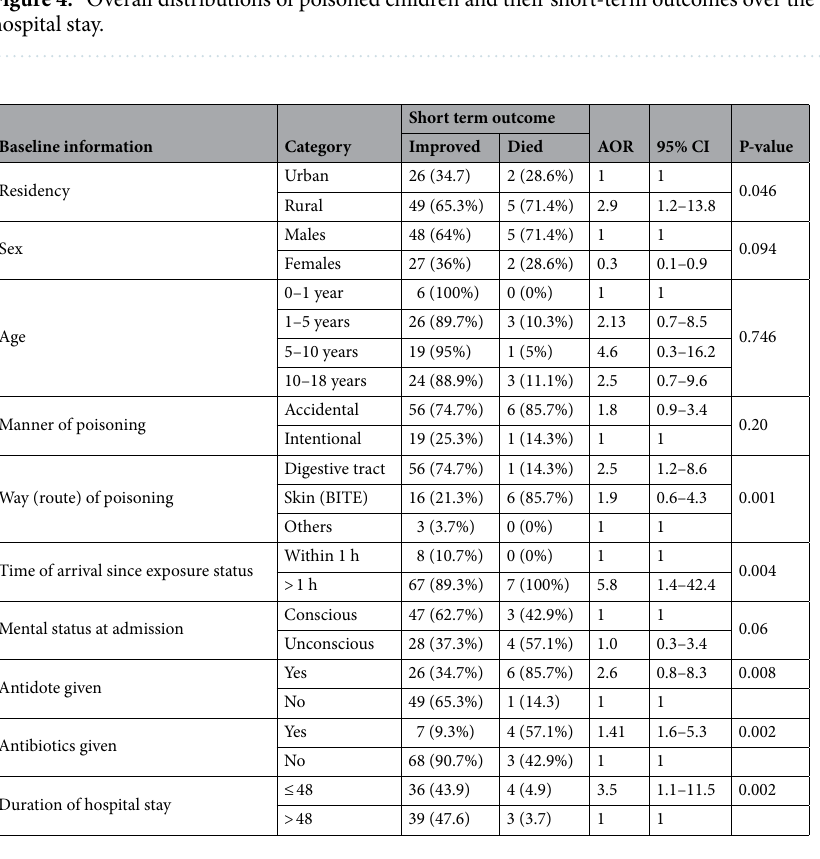
Table 3. Factors associated with short-term outcome of acute poisoning (bivariate and multivariate logistic regression) among study participants at the University of Gondar Comprehensive specialized hospital, Northwest Ethiopia (n = 82). AOR adjusted odds ratio, CI confidence